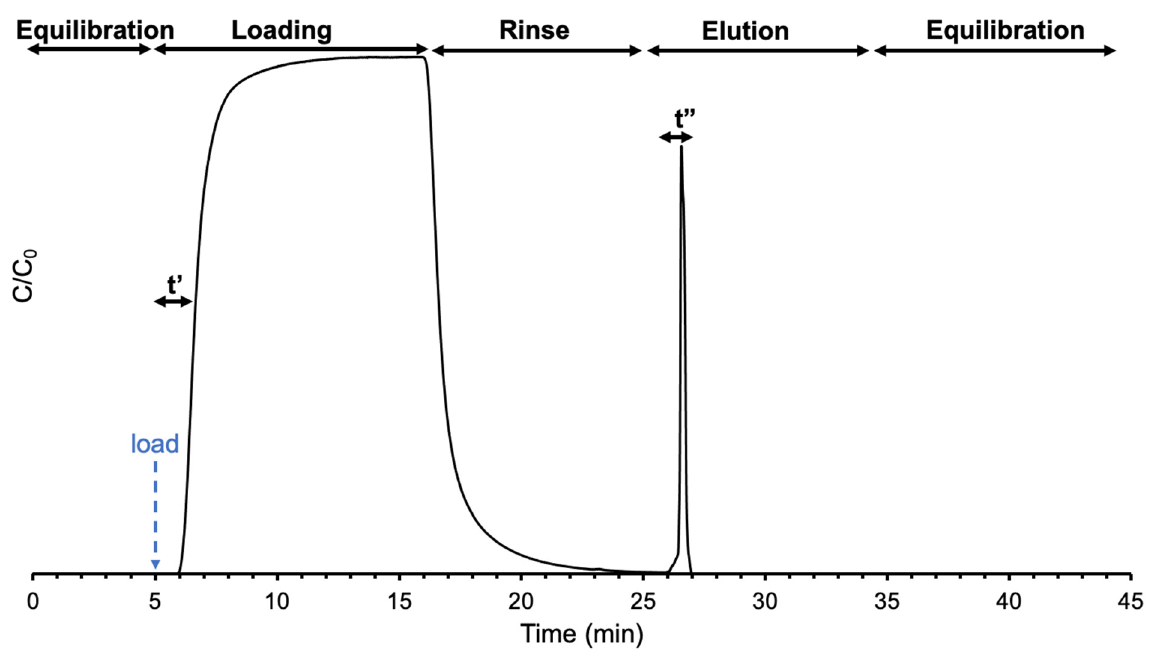
Figure 1. Temporal evolution of EV load/elution experiments with specific designations for throughput and yield computations as defined by Equations (1) and (2).